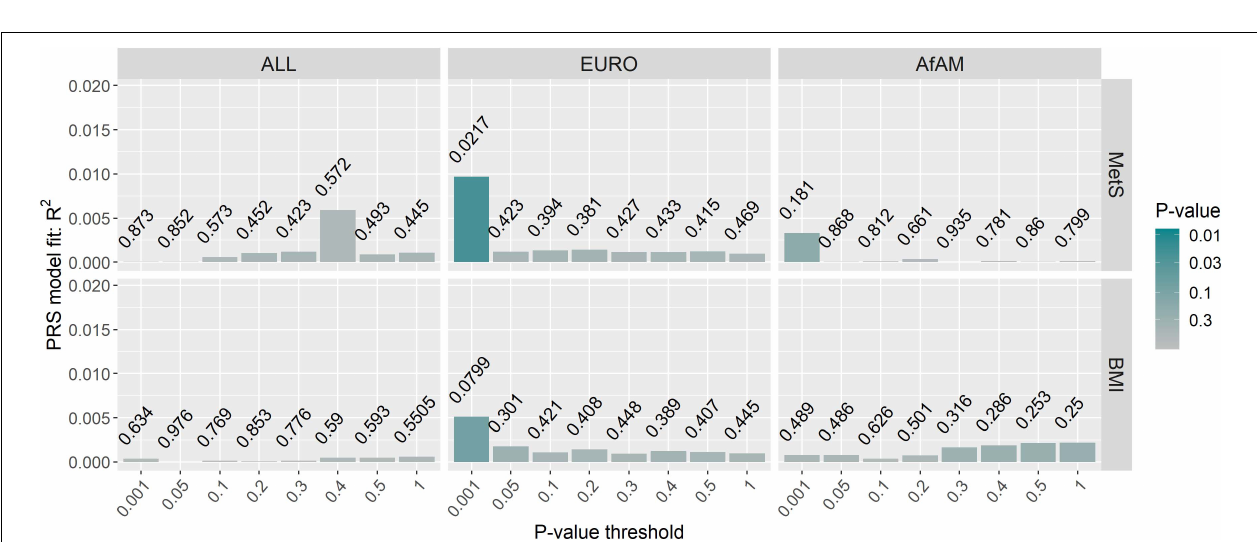
FIGURE 4 | PTSD-PRS prediction for metabolic syndrome-related phenotypes. The lowest p -value was obtained at P T1 − EURO = 0.001 using the European (EURO) PGC-PTSD Freeze 2 GWAS summary statistics ( p = 0.0217). This explained 0.97% of the variation in MetS diagnosis. Results were not significant after Bonferroni correction for multiple testing ( p > 0.00625). MetS, metabolic syndrome diagnosis; BMI, body mass index; ALL, overall PGC-PTSD Freeze 2 data; EURO, European ancestry; AfAM, African American ancestry.